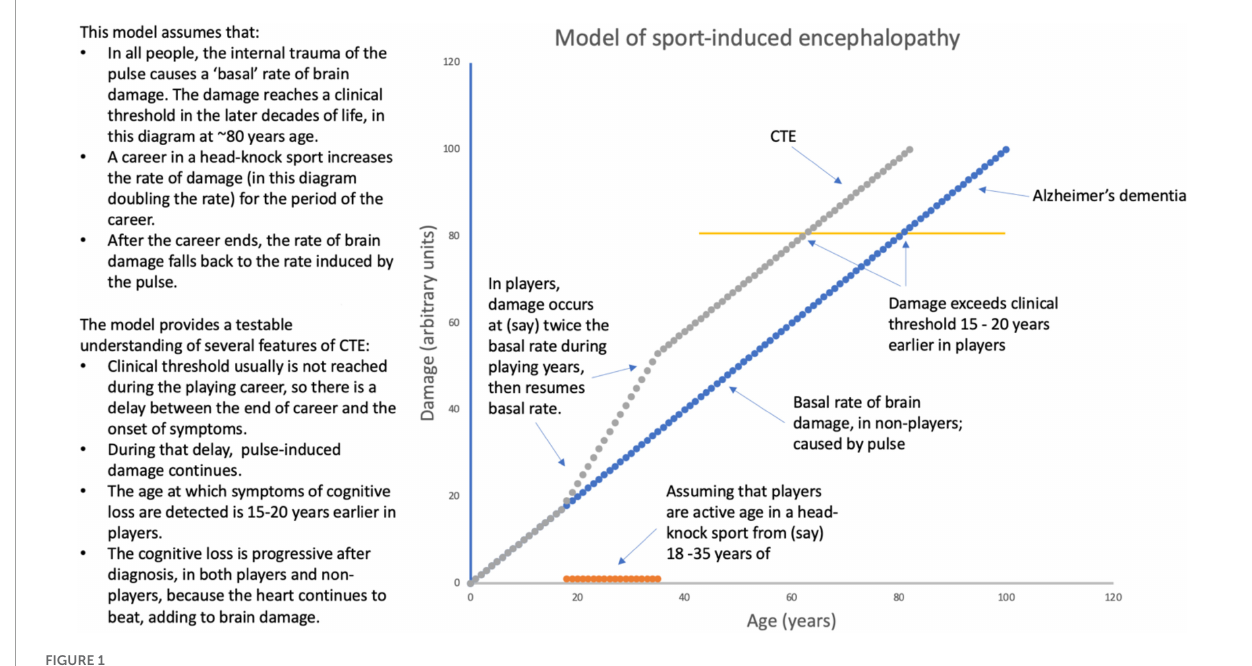
FIGURE1 A model of sport induced encephalopathy